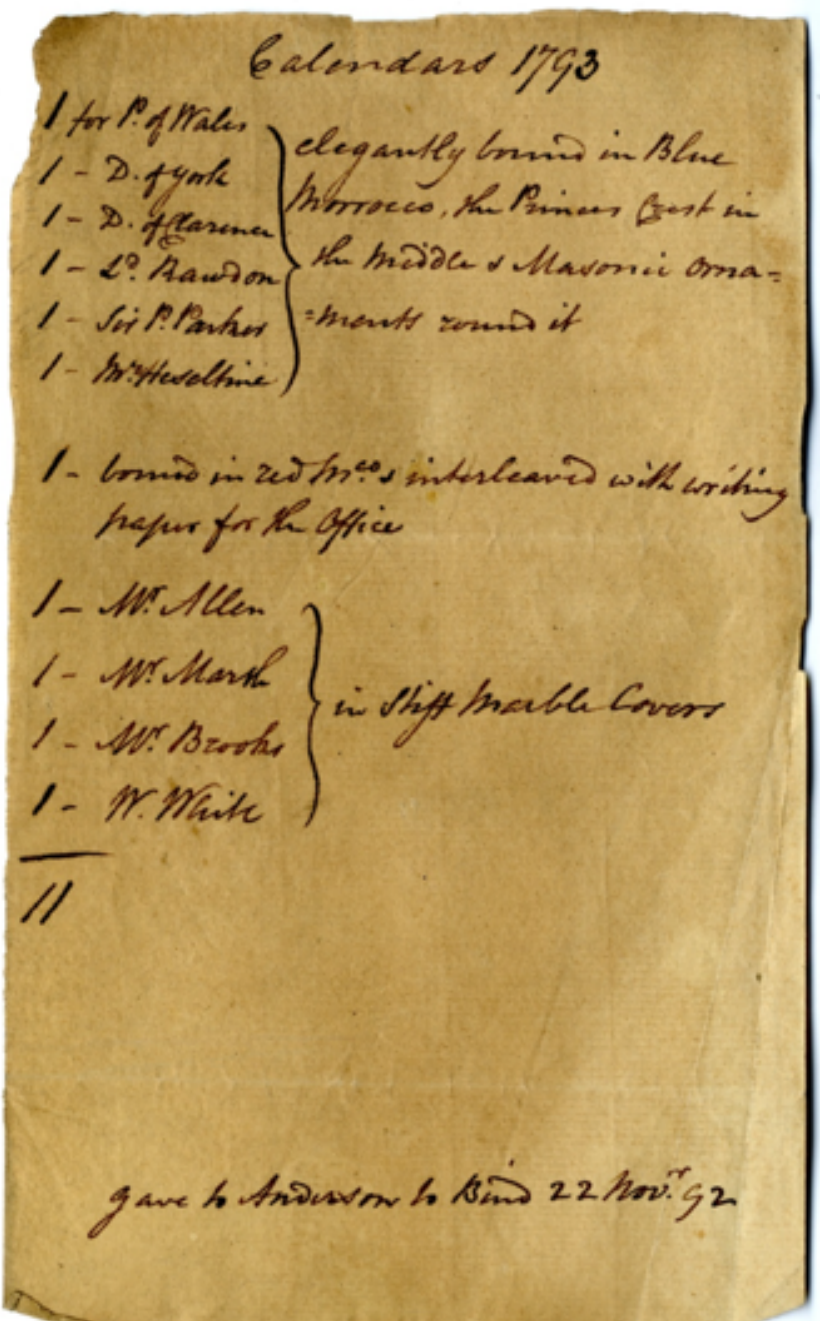
Fig. 39. Note to bookbinder ordering eleven Calendars for the year 1793 for the Prince of Wales and associates [GBR 1991 FMH HC 10/B/44b]. Copyright and reproduced by permission of the Museum of Freemasonry,